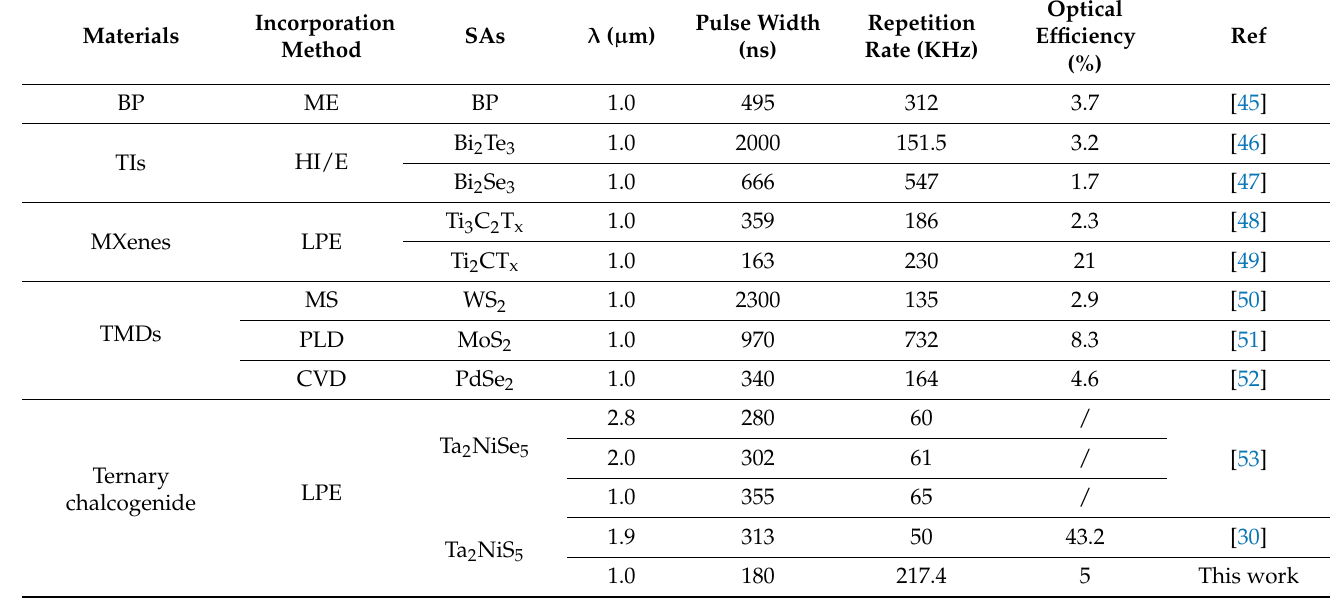
period of high-power excitation. Thus, the as-prepared Ta 2 NiS 5 -SA would be a good candidate for PQS solid-state lasers in the NIR region. Table 1. Comparison of PQS solid-state lasers with different new 2D Materials-SAs.